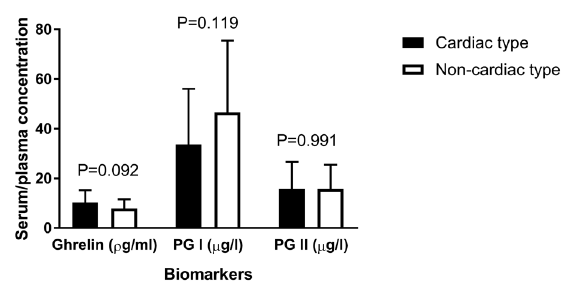
Figure 1: Comparison of plasma ghrelin and serum concentration of PG I and II in two types of gastric cancer. Data are considered as standard deviation (Means ±